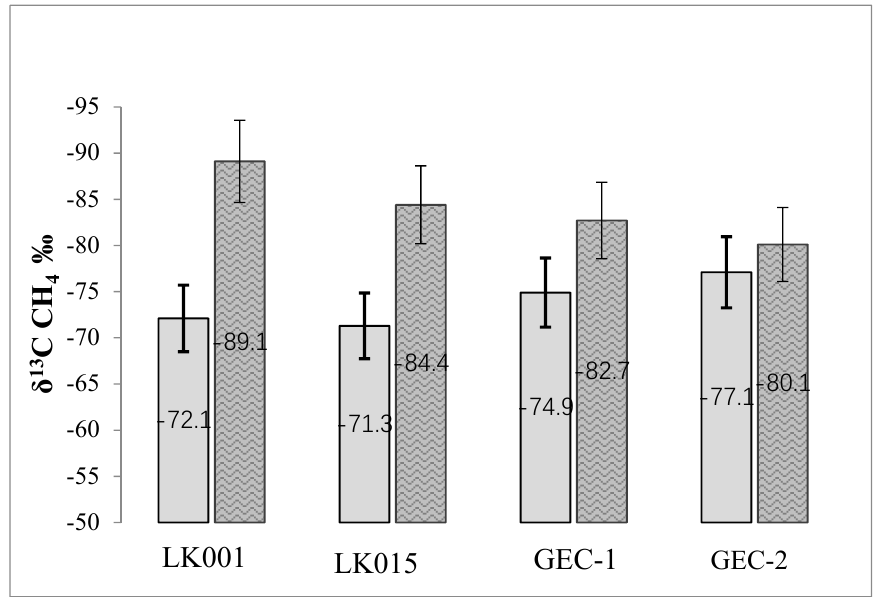
Figure 4. The average values of the isotopic composition of the methane carbon ( δ 13 C CH 4 ‰) in the bottom water (light shadowing) and the bottom sediments from 0 to 14-cm depth (dark shadowing) of the Yamal background lakes (LK001, LK015) and gas emission crater lakes (GEC-1, GEC-2) (April 2018).